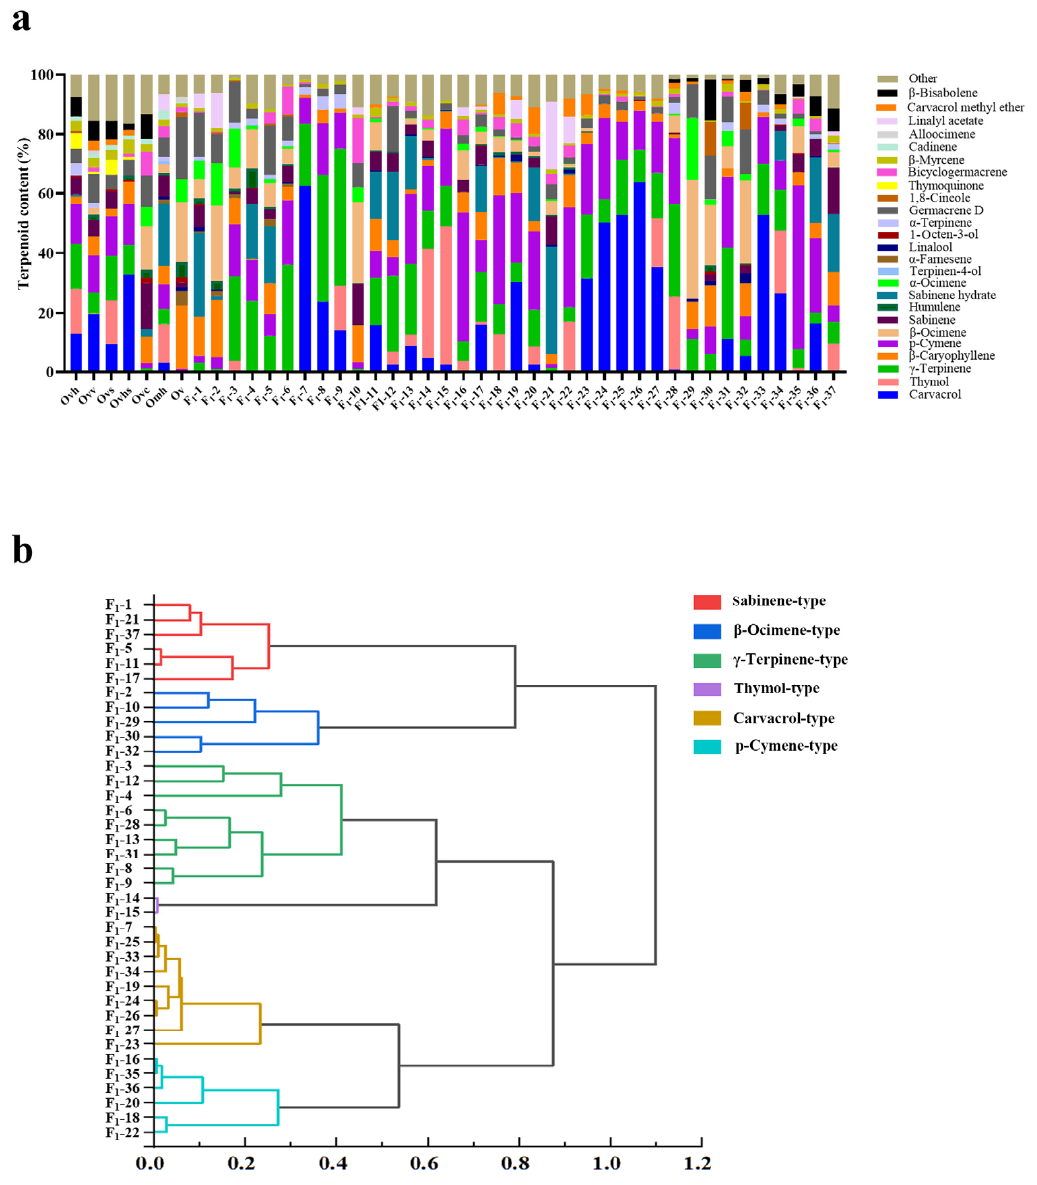
Figure 6. Analysis of volatile terpenoids in the leaves of seven parents and 37 F 1 lines of six hybrid combinations. ( a ) Histogram of volatile terpenoids in the leaves of parental genotypes (Ovh, Ovv, Ovs, Ovhs, Ovc, Omh, and Ov) and 37 F 1 lines. ( b ) Cluster analysis of 37 F 1 lines, based on their terpenoid contents.